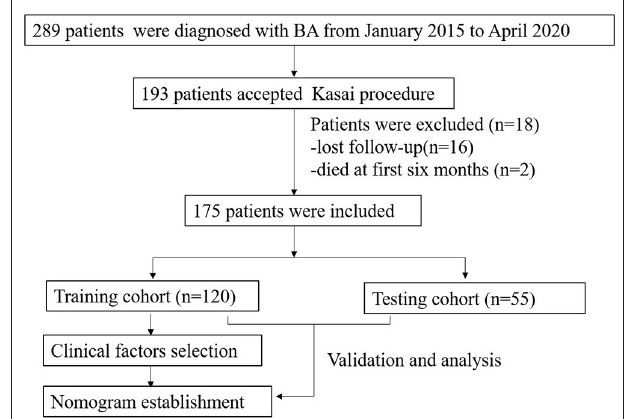
FIGURE 1 | The work flow of this